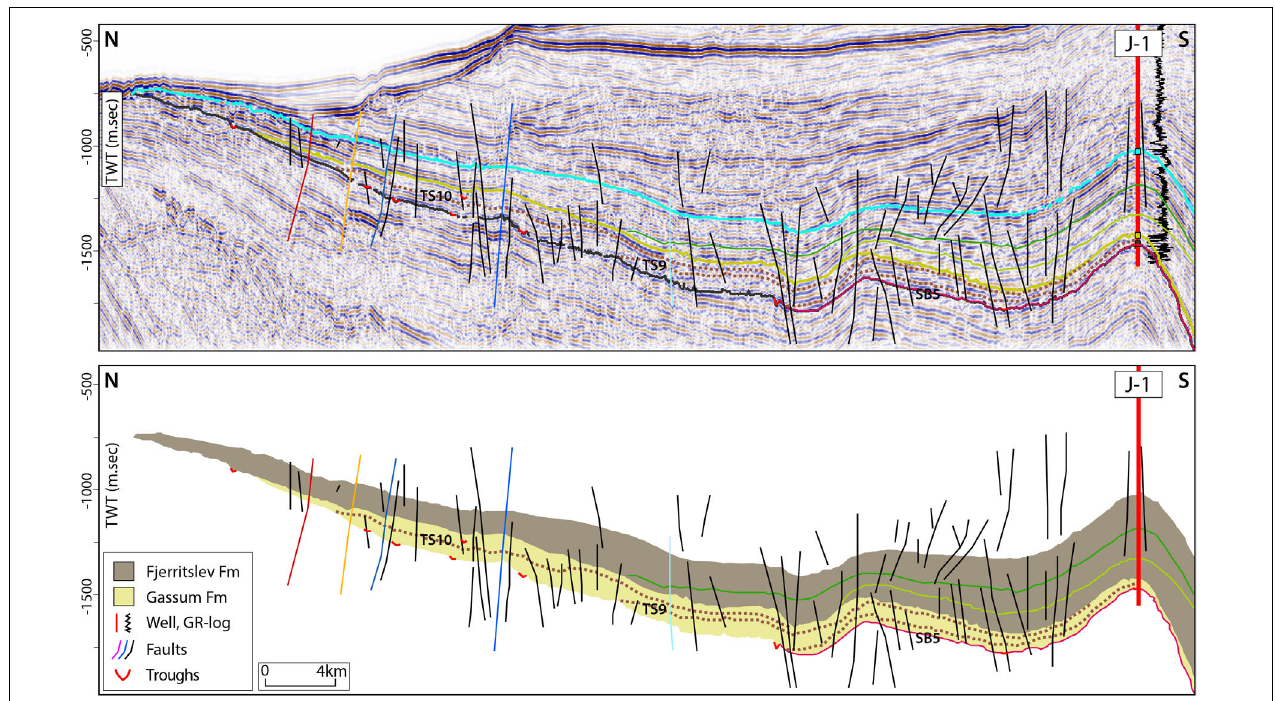
FIGURE 3 | Seismic profile from the Skagerrak located in the eastern part of the study area. The J-1 well is projected a short distance onto the profile (see Figure 1 ). See caption of Figure 2 for further